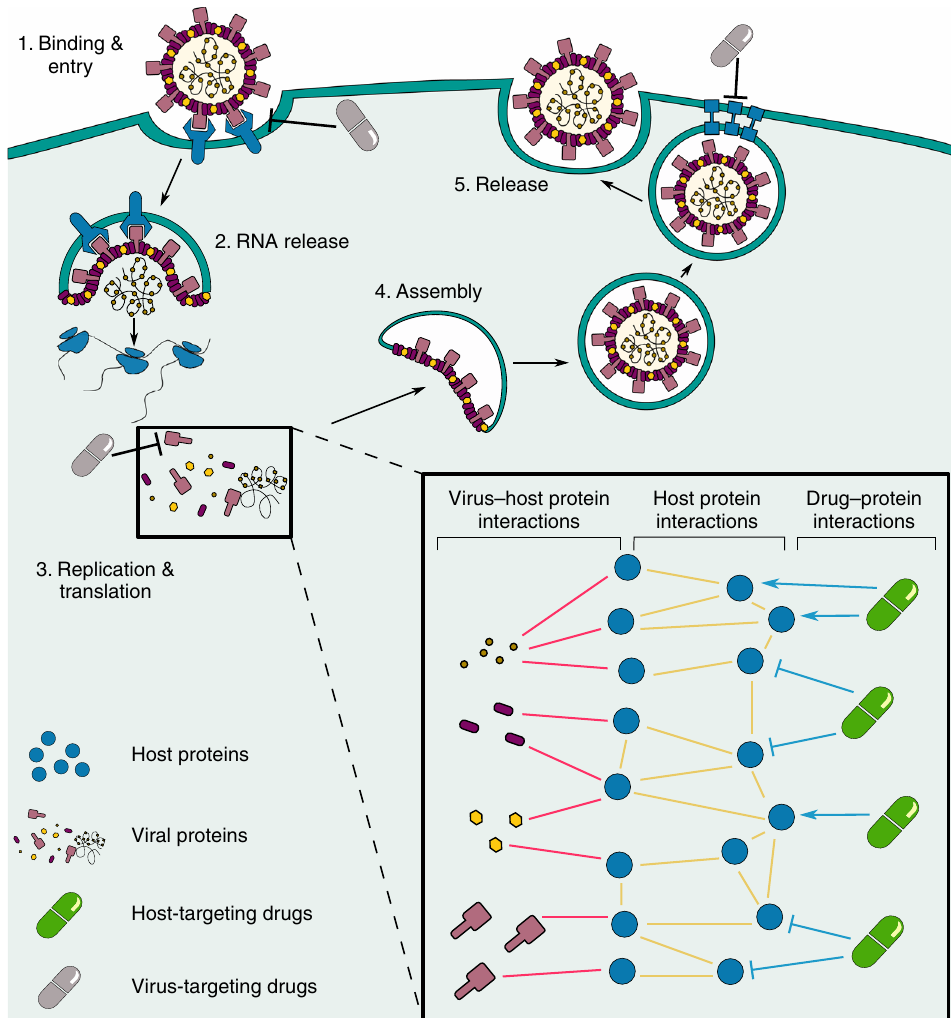
Fig. 1 The SARS-CoV-2 life cycle and the CoVex systems medicine approach of drug repurposing. Most antiviral drugs (gray drugs) target the virus proteins or their direct host interactor proteins to inhibit different stages of the viral life cycle. Our rationale, however, is that viral interactions with human host proteins have a cascading effect to hijack and control key proteins necessary for the virus ’ life cycle. We aim to identify repurposable drug candidates (green drugs) targeting these key host modulators to interfere with virus replication and disease progression following infection. Besides an increased antiviral drug repertoire, targeting host proteins would make it more dif fi cult for the virus (population) to develop resistance